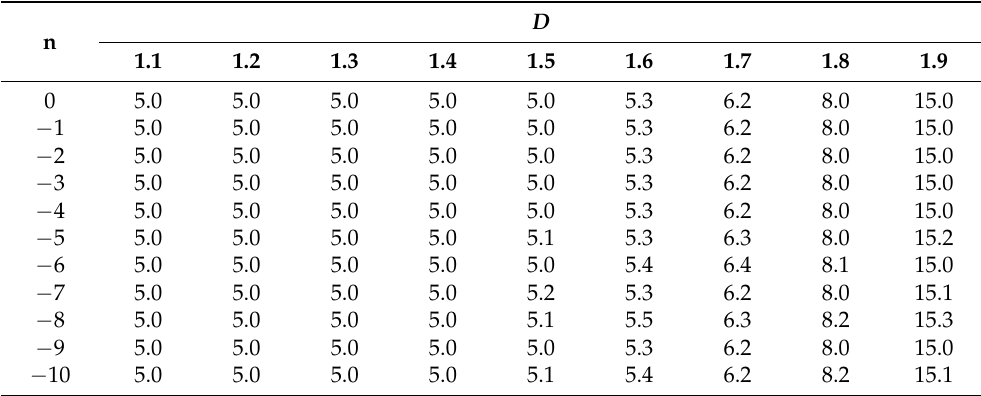
Table A8. L c of drop points under all initial values of n and all fractal